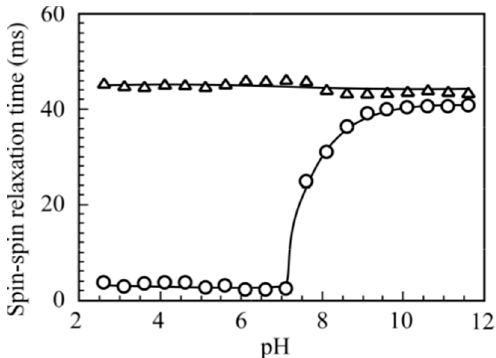
Figure 1. The 500 MHz 1 H NMR spectrum for PAMPS-PAaU at C p = 10 g/L in D 2 O containing 0.1 M NaCl at pH 10.